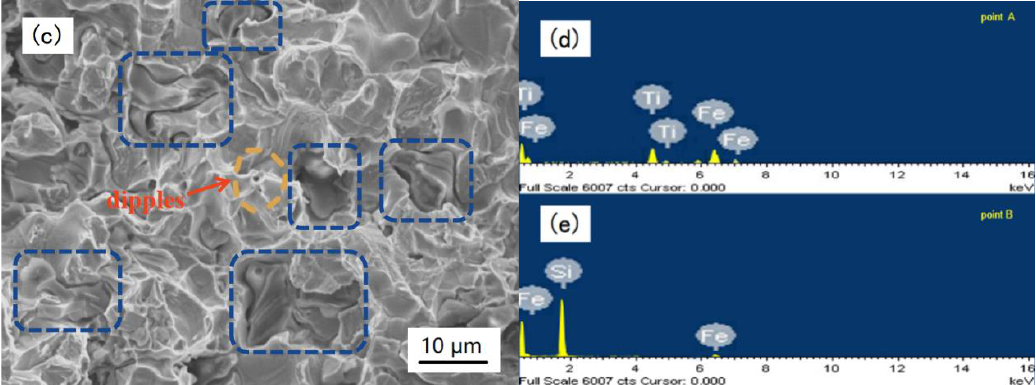
Figure 6. SEM images of the fracture surface of the samples with ( a ) 20% (Ti 3 AlC 2 + SiC), ( b ) 20% SiC, ( c ) 20% Ti 3 AlC 2 , ( d ) EDS results of point A in ( a ), and ( e ) the EDS results of point B in ( a ). SiC is indicated by the yellow rectangle box and TiC x is indicated by the blue rectangle box in ( a – c ).